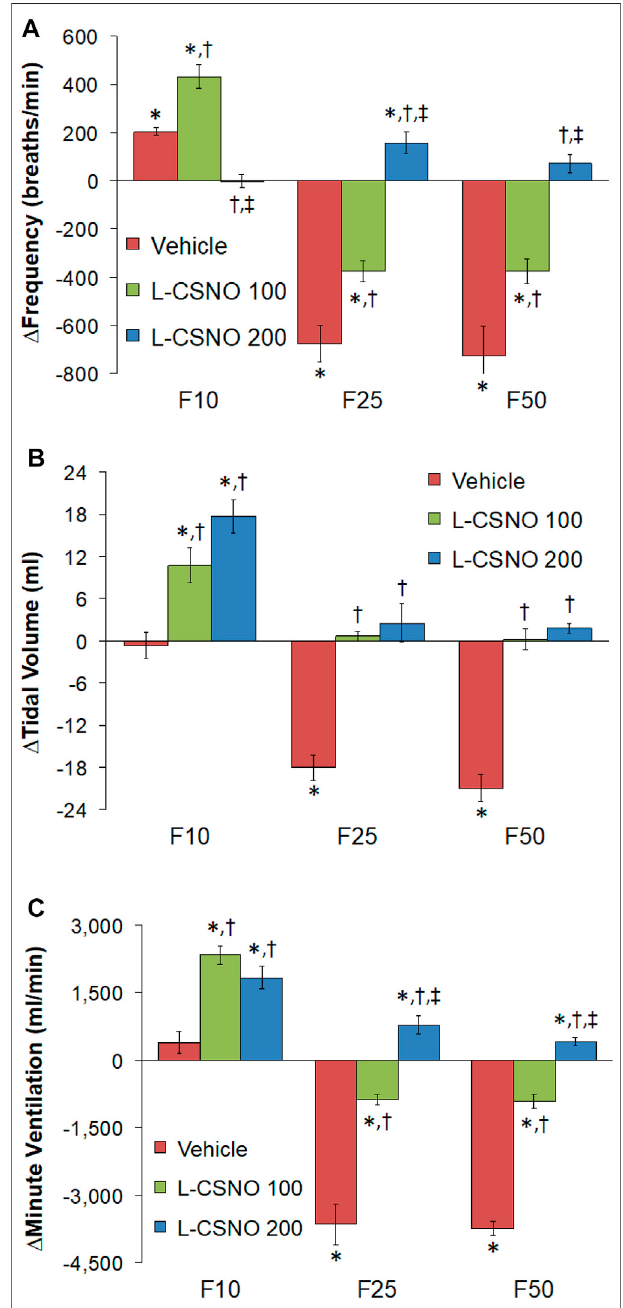
FIGURE 4 | Total arithmetic changes in baseline frequency of breathing (A) , tidal volume (B) , and minute ventilation (C) during the 30 min period following injection of fentanyl at F10 (10 μ g/kg, IV), F25 (25 μ g/kg, IV) and F50 (50 μ g/kg, IV) in rats receiving intravenous infusion of vehicle (20 μ l/min, IV), L-CSNO 100 (S-nitroso-L-cysteine, 100 nmol/kg/min, IV) or L-CSNO 200 (S-nitroso-L-cysteine, 200 nmol/kg/min, IV). The data are presented as mean ± SEM. There were 8 rats in each group. * p < 0.05, signi fi cant change from Pre values. † p < 0.05, L-CSNO 100 or L-CSNO 200 versus vehicle. ‡ p < 0.05, L-CSNO 200 versus L-CSNO